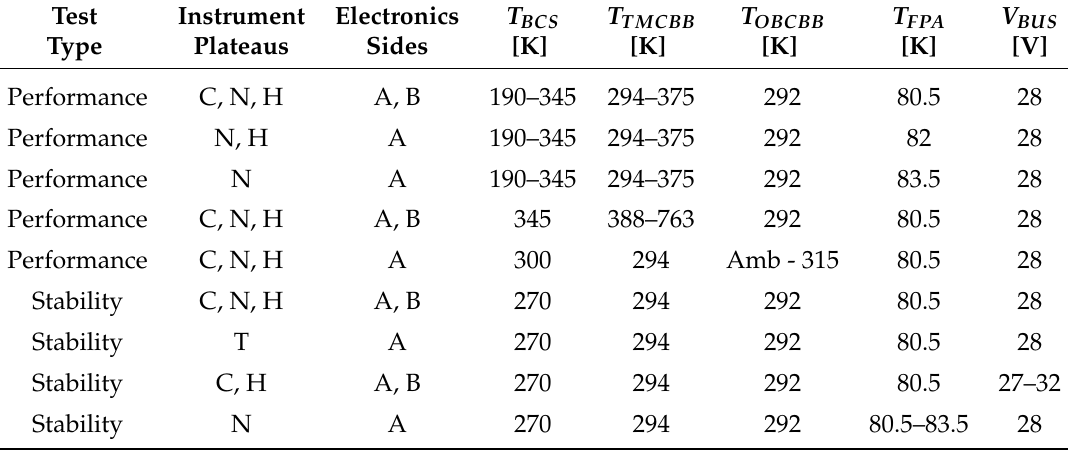
Table 2. Radiometric testing performed for JPSS-1 VIIRS emissive bands during environmental testing [10]. C, N, and H refer to cold, nominal, and hot instrument plateaus; T refers to transitions between instrument plateaus. A and B denote the primary and redundant electronic hardware configuration